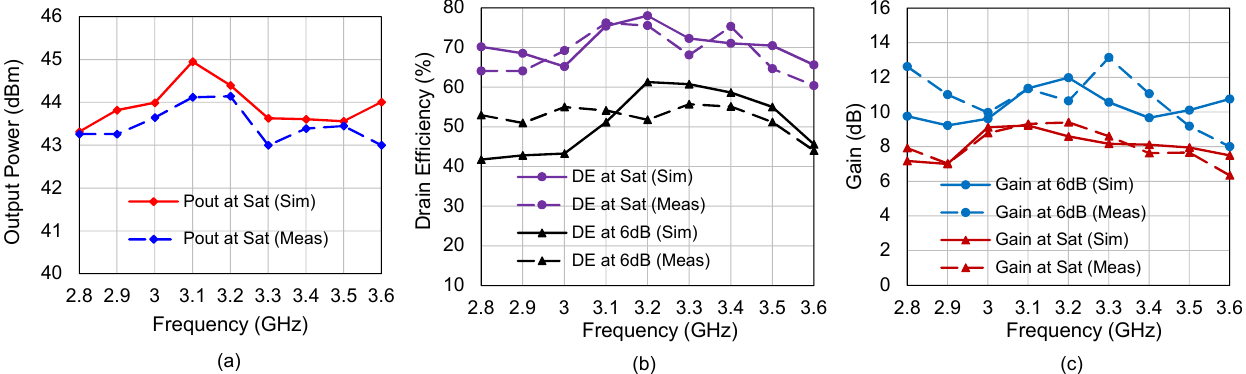
Figure 16. Comparison of simulated (solid) and measured (dashed) large signal performance versus frequency: ( a ) saturated output power and ( b ) drain efficiency and ( c ) gain at saturation and 6 dB back-off.